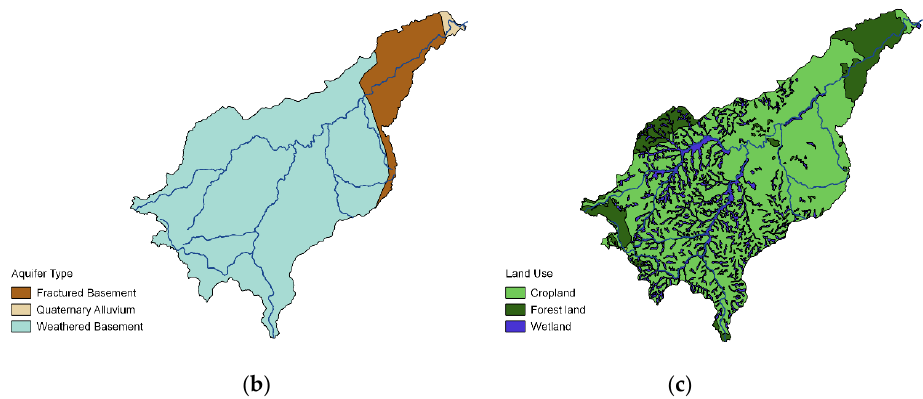
Figure 1. ( a ) Location of Malawi in Africa (insert), location of the Bua catchment in Malawi (insert) and digital elevation model of the Bua catchment (WRA 5) with rivers, river gauges, weir, rainfall stations and groundwater monitoring; ( b ) aquifer type map [35]; ( c ) land use map [32].